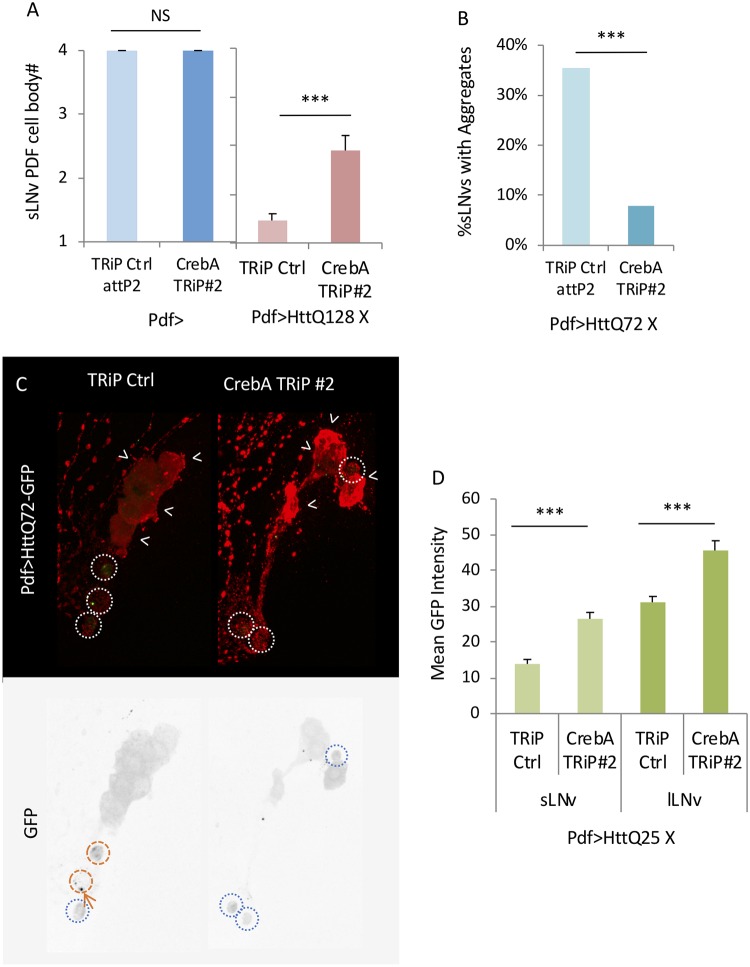
CrebA knockdown suppresses mHtt induced PDF+ cell body loss and aggregation despite elevated Htt levels.A. The number of sLNv present per brain hemisphere at age day 10 is indicated for various genotypes where either CrebA RNAi (CrebA TRiP#2) or TRiP RNAi library control (TRiP Ctrl) without (n = 4–6) and with HttQ128 are expressed is shown (n = 20–26; *p<0.05, **p<0.01, ***:p<0.005, error bars represent standard error). B. Percentage of sLNvs (labelled in red) at age day 7 containing HttQ72-eGFP aggregates (in green) in a TRiP RNAi library control background (TRiP Ctrl) and expressing a CrebA TRiP RNAi lines (CrebA TRiP#2) is quantified (n = 43–44; *p<0.05, **p<0.01, ***:p<0.005, error bars represent standard error). C. Representative images of sLNv and lLNv for corresponding genotypes in B are shown. White arrowheads indicate lLNvs. White dot circles label sLNvs in the merged figure. Orange dash circles label sLNvs with aggregates while blue dot circles label sLNvs without aggregates in the grey scale of the green channel. Example aggregates are pointed out by orange arrows. D. GFP Intensity in the sLNv or lLNv for flies expressing HttQ25 in a TRiP RNAi library control background (TRiP Ctrl) and expressing CrebA RNAi is quantified and shown (n = 8–20; *p<0.05, **p<0.01, ***:p<0.005, error bars represent standard error).